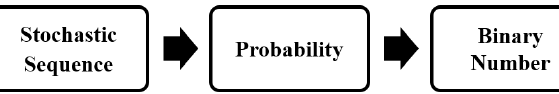
Figure 5. Flow of binary